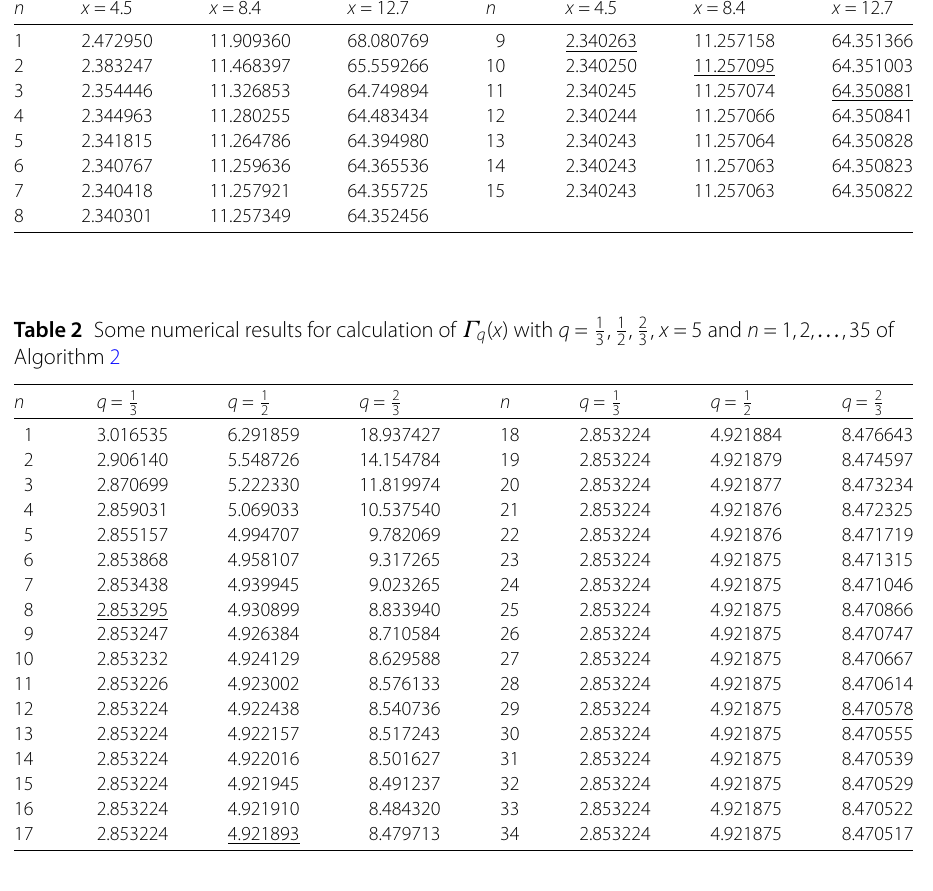
, x = 4.5,8.4,12.7 and 3